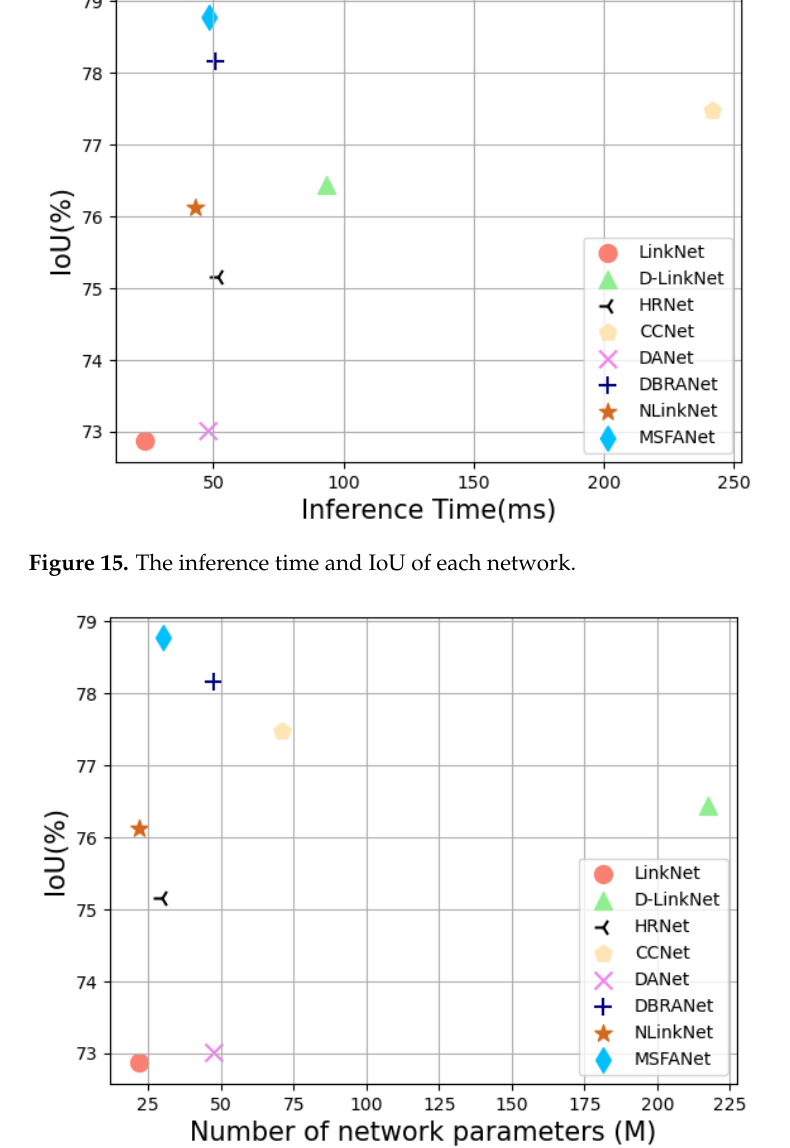
Figure 16. Number of parameters and IoU for each